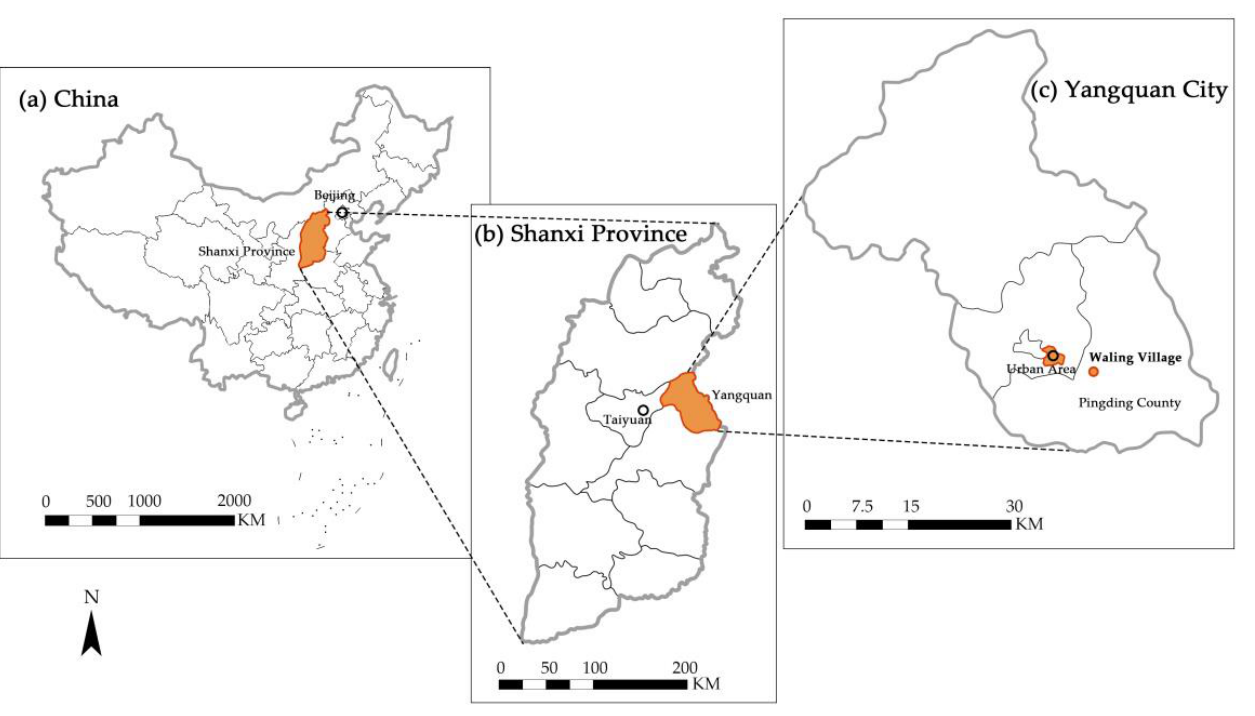
Figure 2. Research